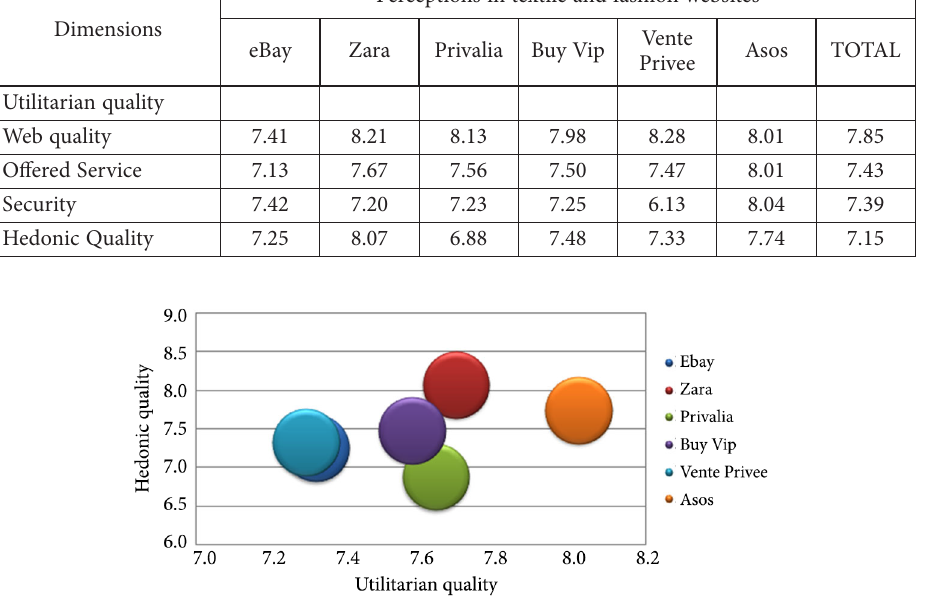
Figure 2. Utilitarian quality versus hedonic